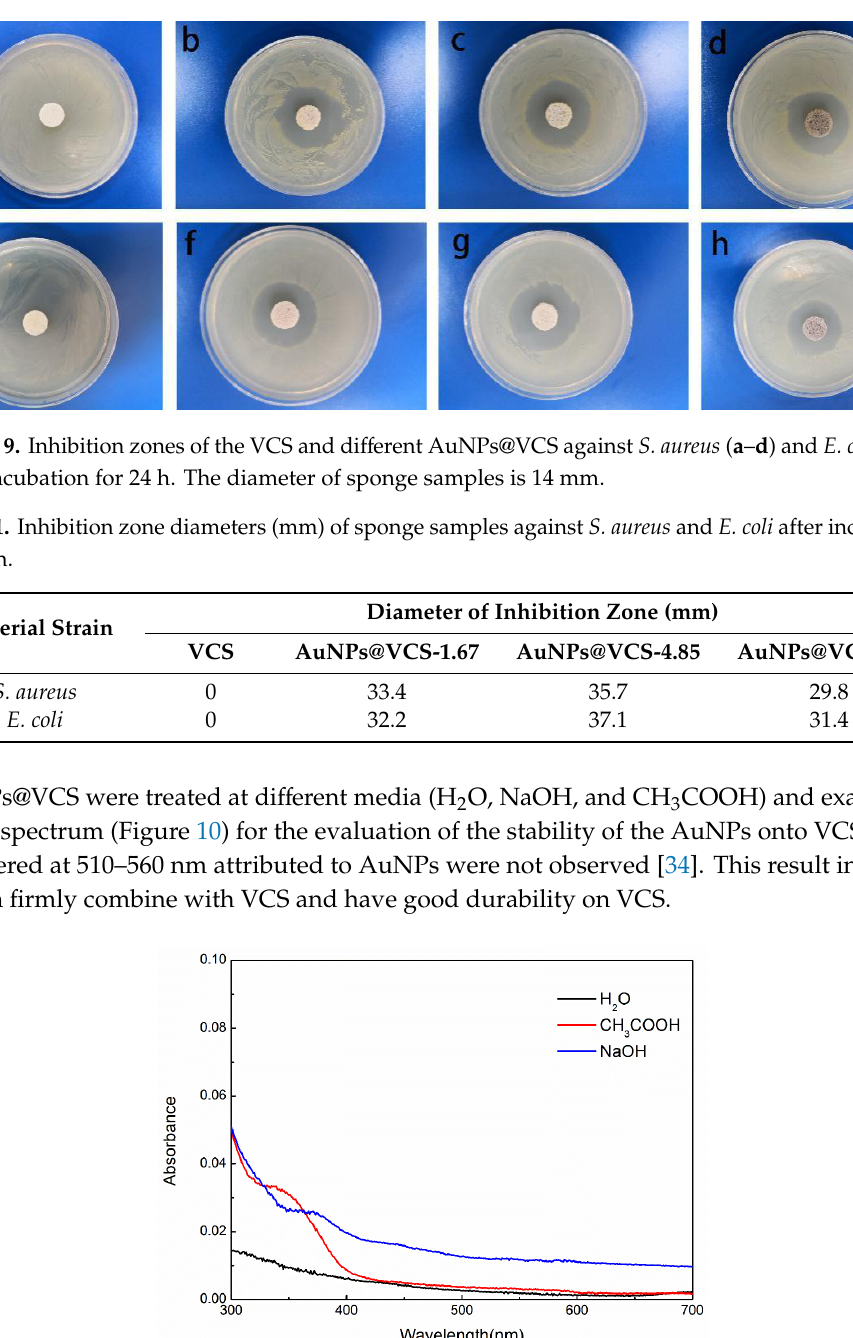
(Table 1). The distinctions of the VCS and AuNPs@VCS against Gram-negative bacteria E. coli and Gram-positive bacteria S. aureus could be attributable to the different structures of their cell wall. Compared with other antibacterial agents, AuNPs, due to their inherent physio-chemical properties, have lower biological toxicity [48,49].